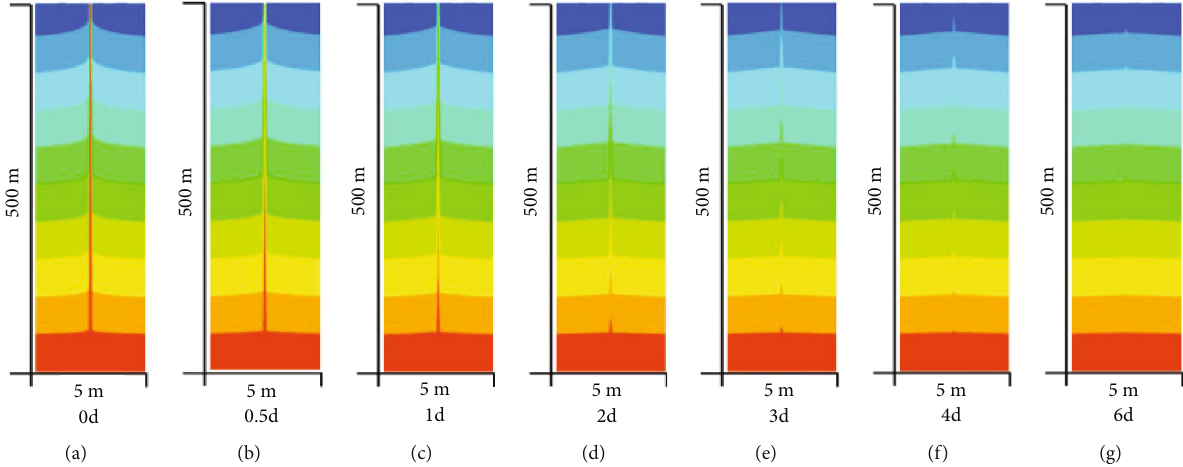
Figure 7: Temperature distribution at di ff erent times after shut-in.